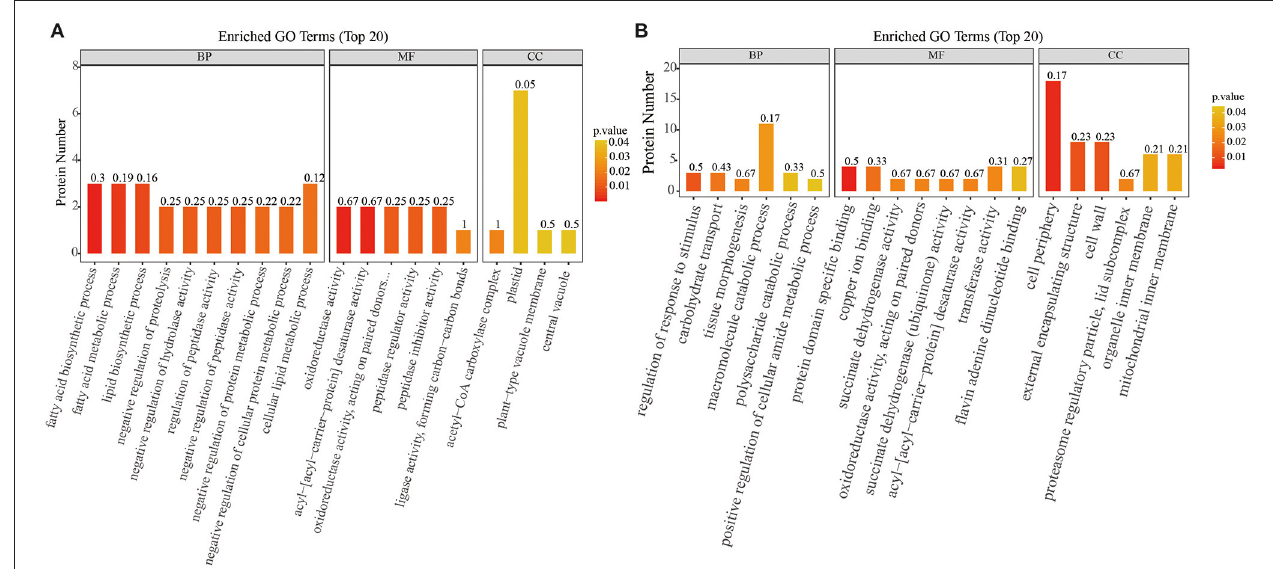
FIGURE 4 | GO enrichment analysis of differentially abundant proteins (DAPs) in HR_UR and FR_HR group. (A) HR_UR; (B) FR_HR. The horizontal axis shows the top 20 enriched GO terms in the biological process, molecular function, and cellular component categories. The vertical axis shows DAPs enriched in each term. The height and color of each histogram indicates the number of proteins and p values of the enriched term. The label of each histogram indicates the rich factor, which represents the ratio of DAPs to total proteins identified in GO functional category.